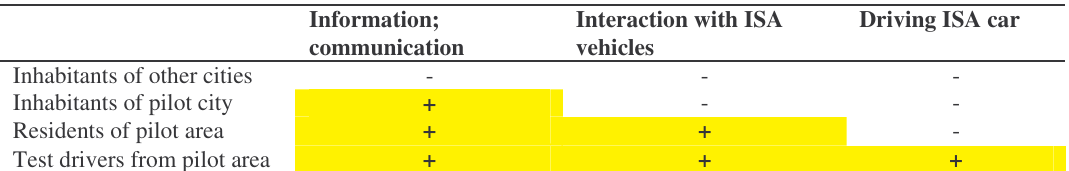
Interaction with